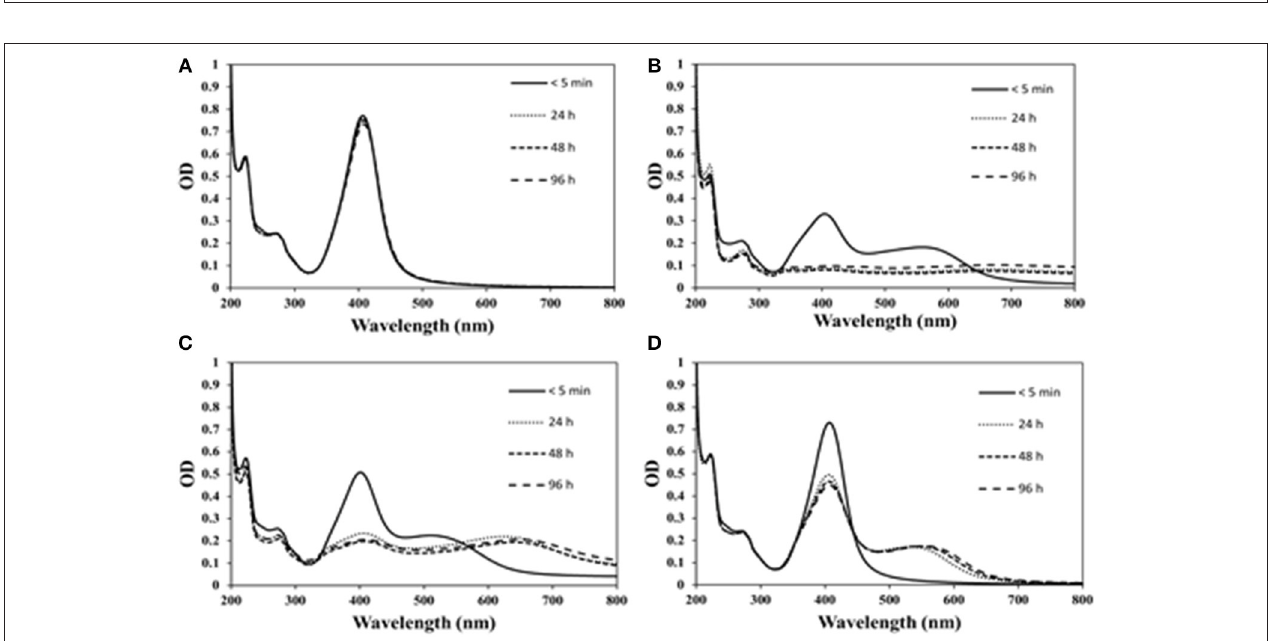
FIGURE 2 | The effect of exposure time on the SPR of Tyr-AgNPs in (A) MilliQ water, (B) hydra, (C) daphnid, and (D) shrimp media.